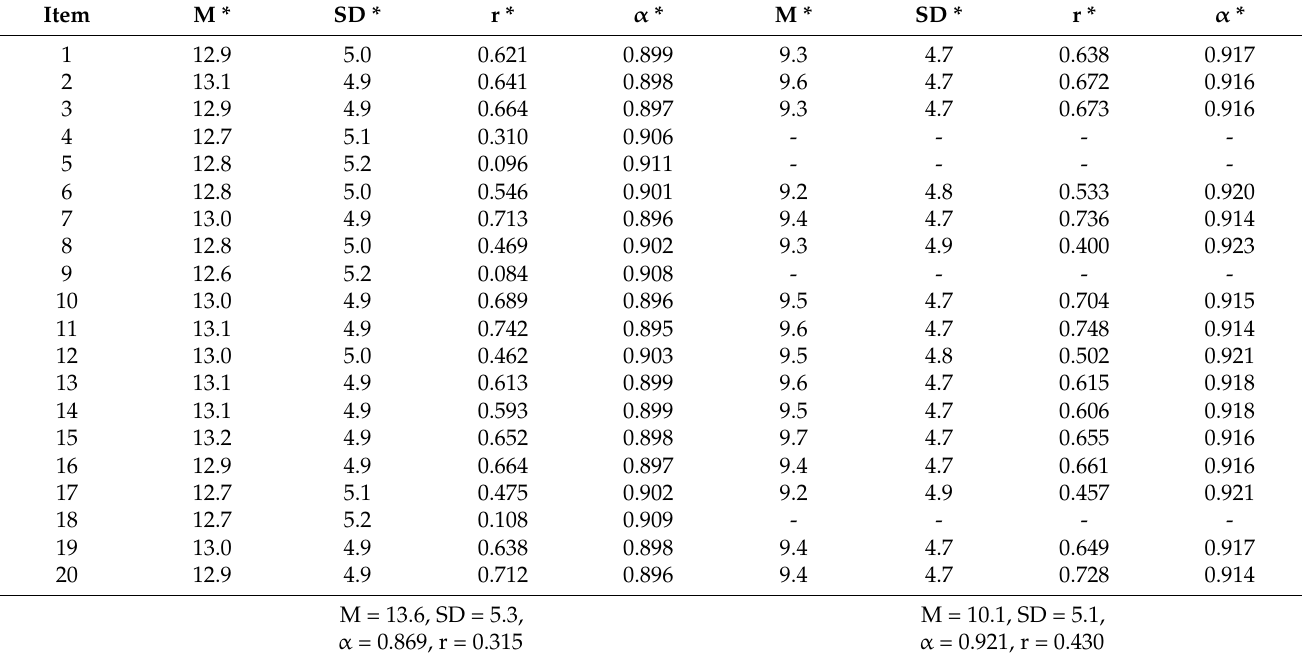
Table 1. An analysis of the reliability of the AS-WIS items and of the scale’s shortened version in a group of 142 patients with